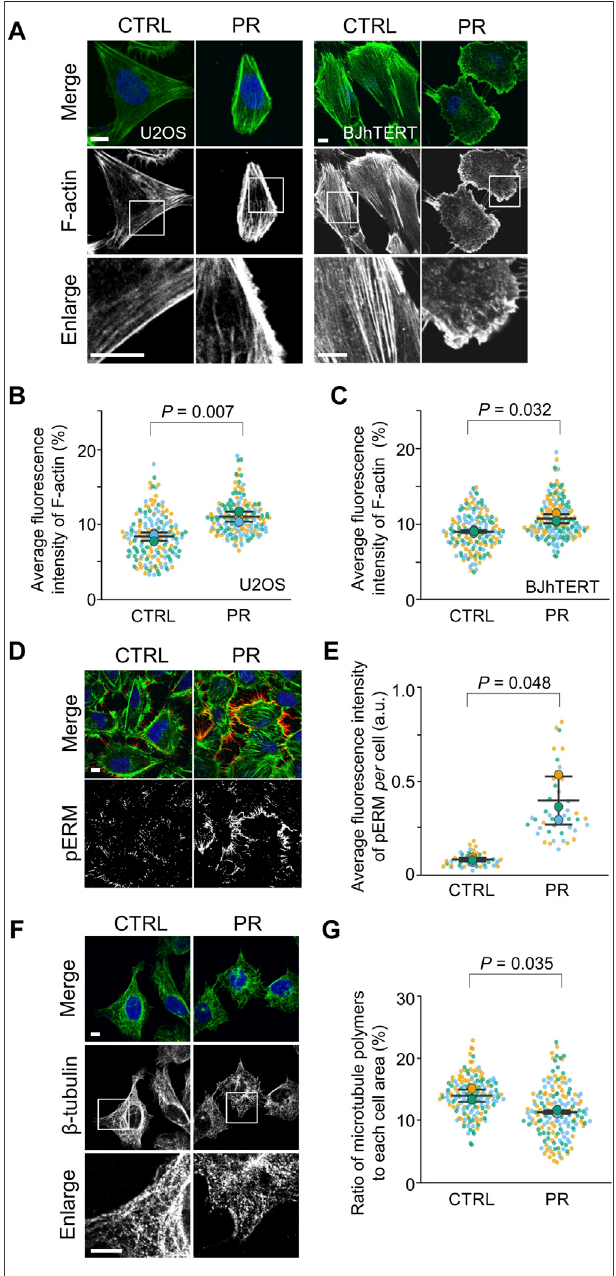
FIGURE 3 | PR 20 changes the organization of F-actin and β -tubulin and promotes the phosphorylation of ERM (pERM). (A) Fluorescent images of phalloidin in U2OS and BJhTERT cells after treatment with 10 µM of PR 20 or CTRL. phalloidin (green) and DAPI (blue) are shown. Scale bars are 10 µm. (B,C) Quanti fi cation of average fl uorescence intensity of F-actin in U2OS cells (in B) and BJhTERT cells (in C). Bars are means ± SD. In each experiment, 50 to 55 cells were evaluated ( n = 3). p value shows Welch ’ s t -test. (D) FluorescentimagesofpERM(red),phalloidin(green)andDAPI(blue) after treatment with or without 10 µM of PR 20 in U2OS cells. A bar is 10 µm. (E) Average fl uorescenceintensityofpERMpercellaftertreatmentwith10 µM of PR 20 or CTRL. Bars are means ± SD. 15 regions were evaluated ( n = 3). p value shows Welch ’ s t -test. (F) Fluorescent images of β -tubulin in U2OS cells after treatment with 10 µM of PR 20 or CTRL. Bars are 10 µm. (G) The ratio of ( Continued )